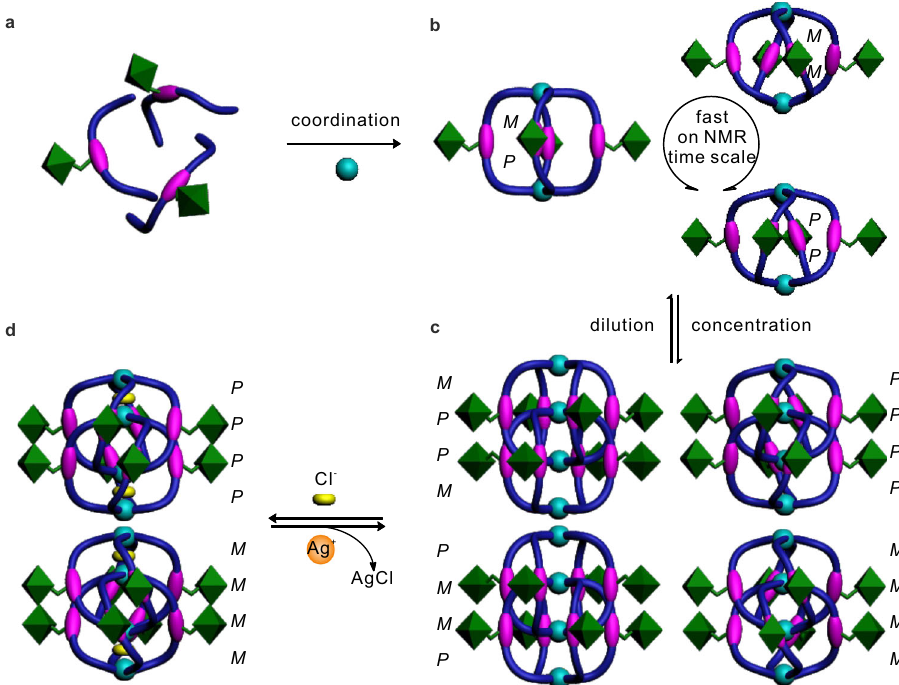
Fig. 3 Schematic representation of the chirality dynamics and hierarchical communication of the helicates. a A mixture of sequences with different twisting conformations. b The monomeric helicates with three conformations ( PM , MM , and PP ) in fast exchange on the NMR timescale. c Four isomers ( PPPP , MMMM , PMMP , and MPPM ) of the dimeric helicates exist due to the communication of the ligands. d Two conformations ( PPPP and MMMM ) of the dimeric helicates complexed with two Cl − anions.